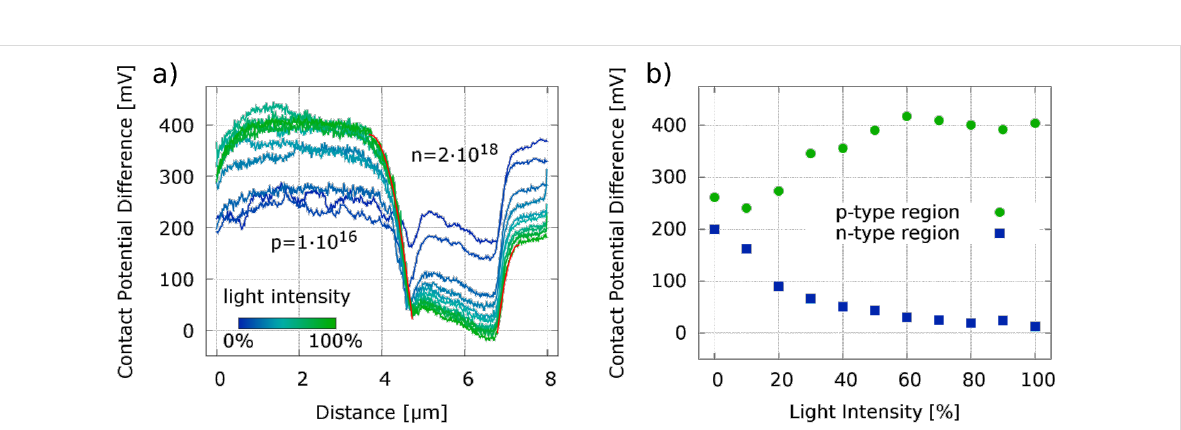
Figure 7: Panel a shows sections across the SiC p/n-junction (Figure 6) extracted from images taken at various light intensities. The data were aver- aged over five lines taken along the middle of the scan area. The averaged CPD values in the p- and n-type areas approach constant values under illumination as shown in panel b. In red are shown fits of the SCR regions of both junctions from the 100% illuminated sample calculated through Equation